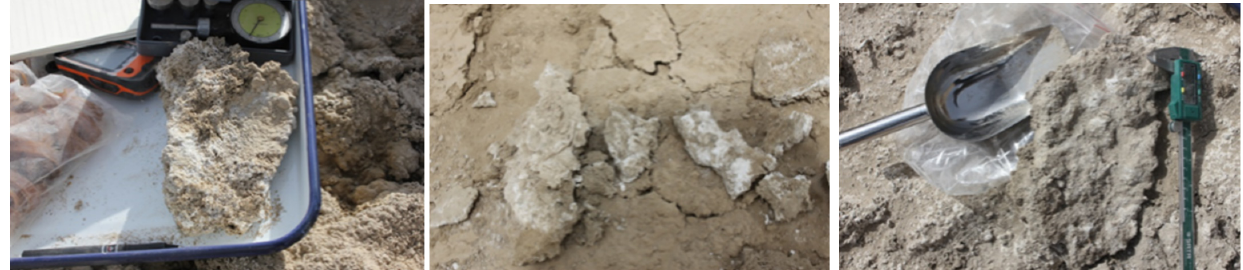
Figure 7. Salt crusts on topsoils in the Tarim River Basin.